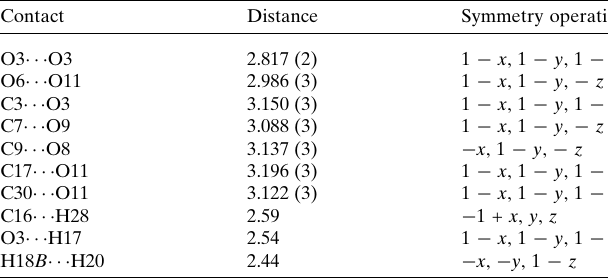
Table 2 Summary of short interatomic contacts (A˚ ) in (I).